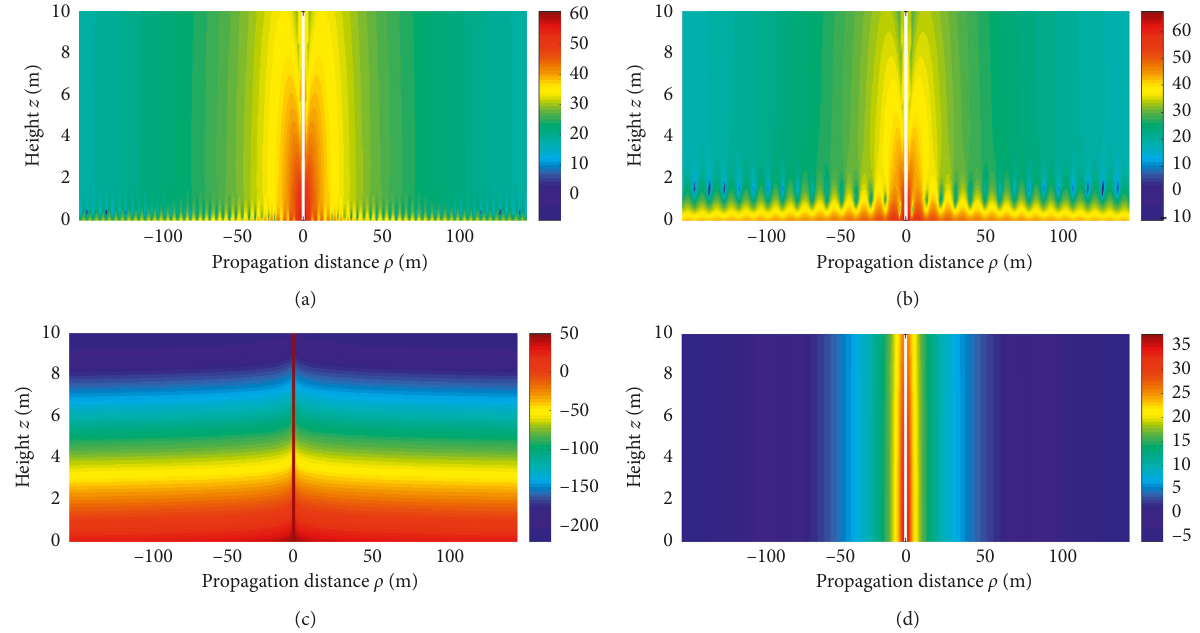
Figure 11: Spatial distributions in 􏽢 ρ − 􏽢 z plane of the electric field | E by two dielectric layers at f � 100MHz; ε r surface wave; and (d) lateral wave.